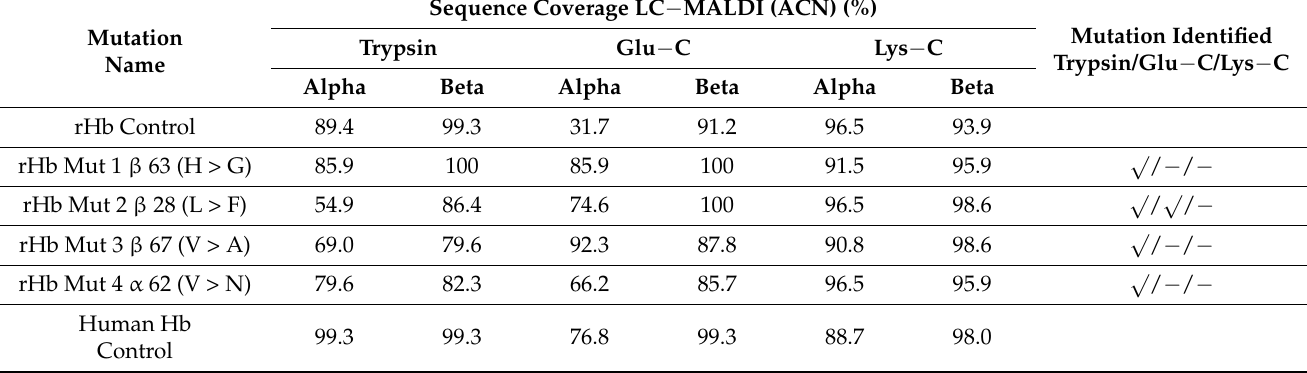
Table 2. Sequence coverage for recombinant Hbs with 10% acetonitrile treated Hbs digested with three different enzymes in LC −